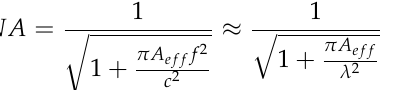
Figure 7. The numerical aperture of the proposed oil detector for different operating frequencies.